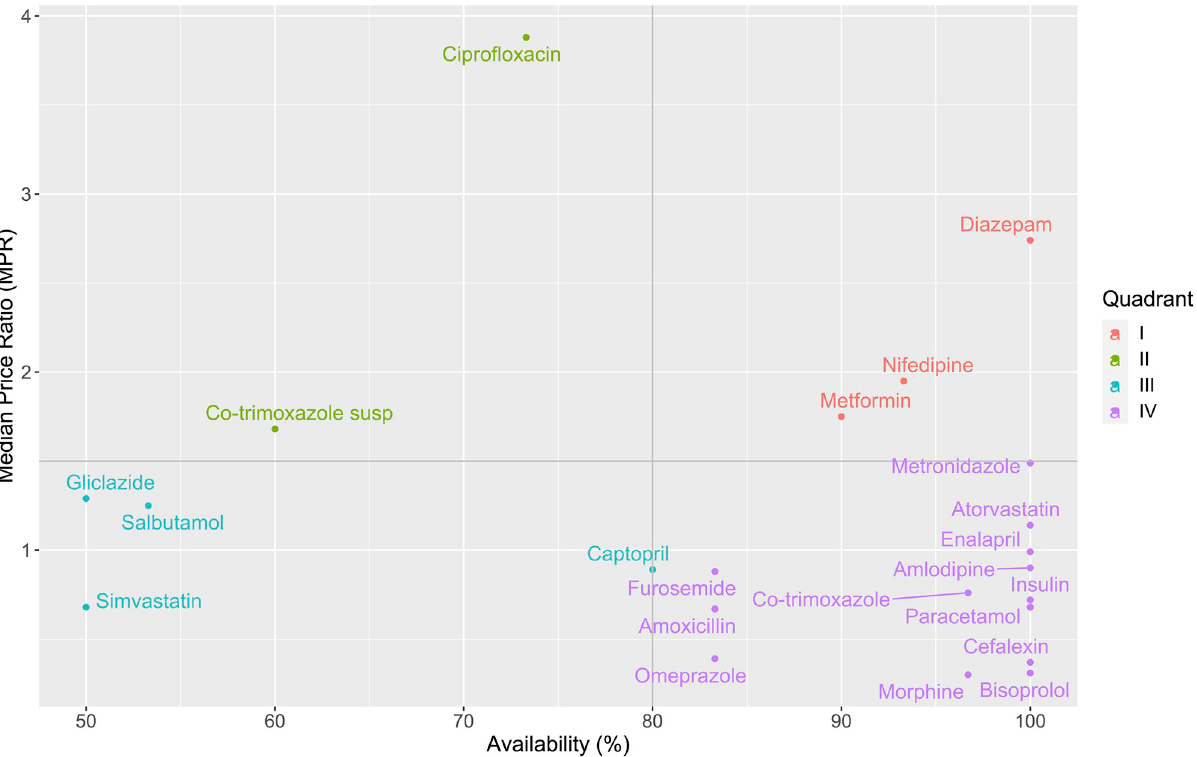
Fig 1. Comprehensive analysis of the availability and prices of LPGs in the public sector. Horizontal line: MPR = 1.5, Vertical line: Availability = 80%, susp: suspension.